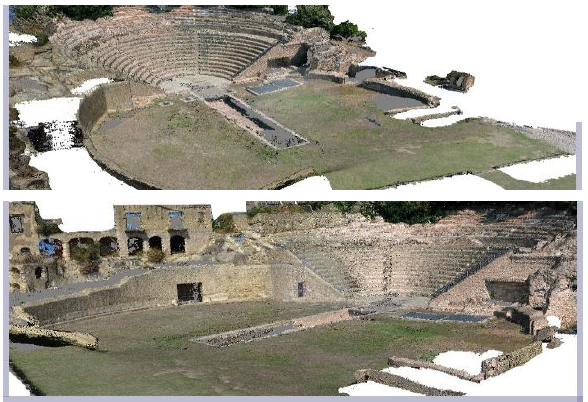
Figure 3: Two different views of the photogrammetric point